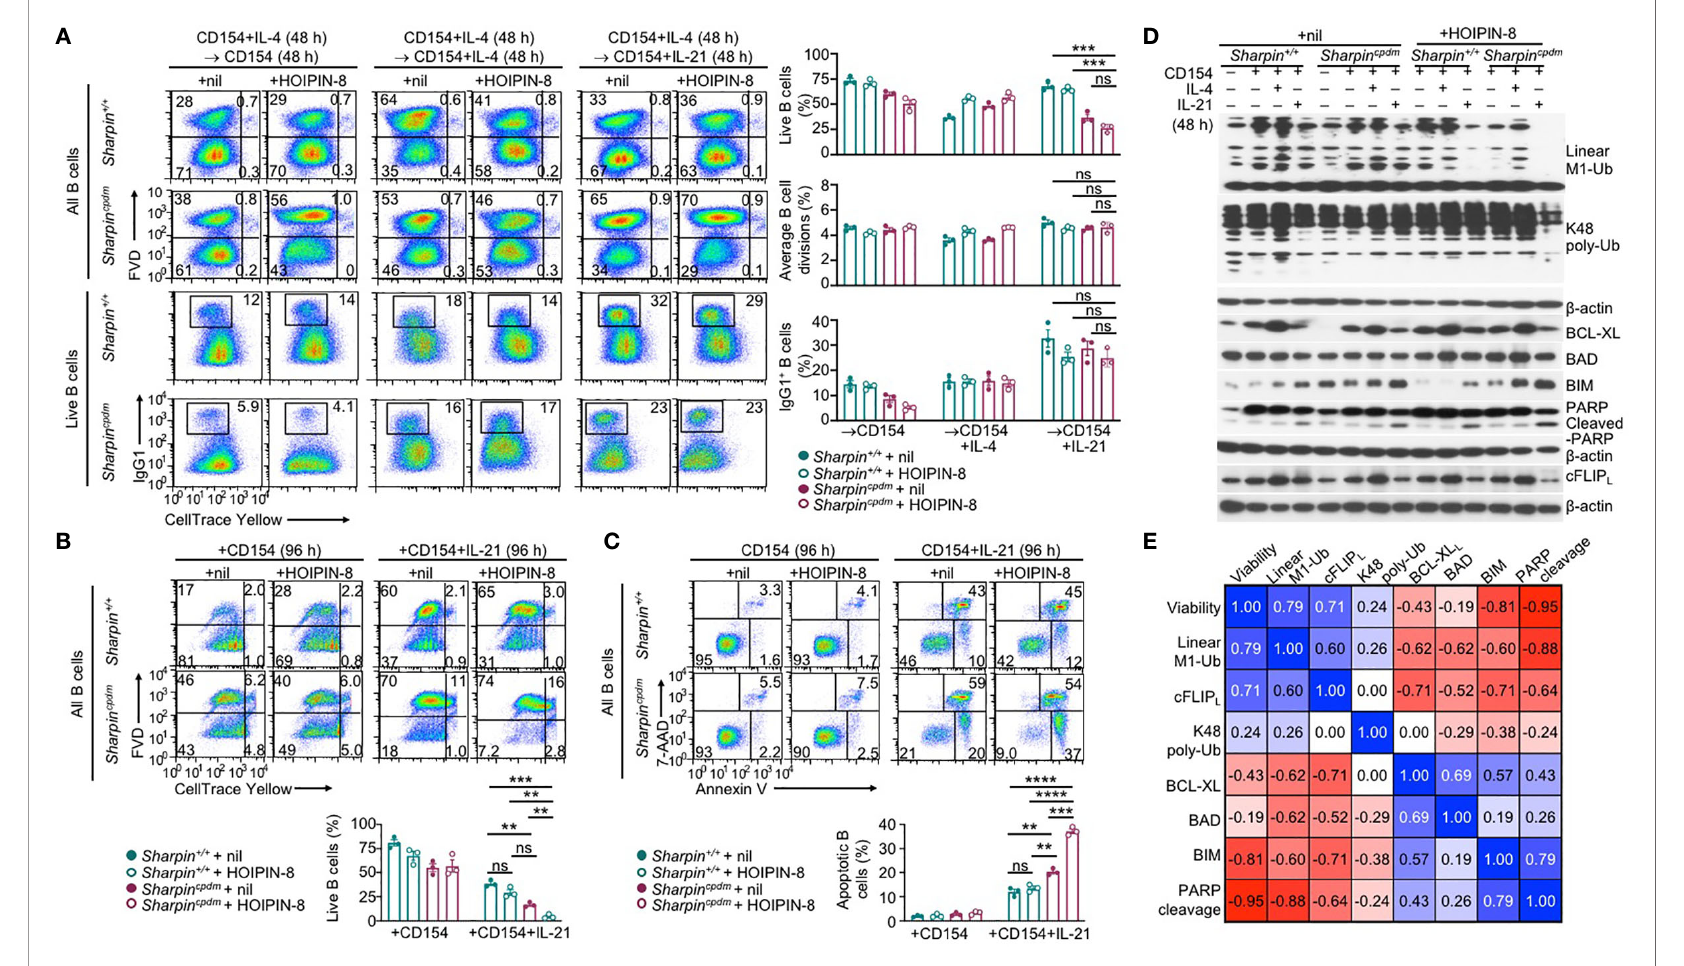
FIGURE 8 | SHARPIN de fi ciency and HOIPIN-8 synergize to promote IL-21-induced cFLIP L loss and apoptosis. (A) Flow cytometry analysis of survival, proliferation, and CSR to IgG1 in Sharpin +/+ and Sharpin cpdm B cells stimulated fi rst with CD154 and IL-4 for 48 h, washed, and then with CD154, alone or plus IL-4 or IL-21, for 48 h in the presence of nil or HOIPIN-8 (20 m M). (B) Flow cytometry analysis of the viability of Sharpin +/+ and Sharpin cpdm B cells stimulated with CD154 or CD154 plus IL-21 for 96 h in the presence of nil or HOIPIN-8. (C) Flow cytometry analysis of apoptosis in Sharpin +/+ and Sharpin cpdm B cells stimulated with CD154 or CD154 plus IL-21 for 96 h in the presence of nil or HOIPIN-8. (D) Immunoblotting analysis of linear M1-Ub, K48 poly-Ub, expression of apoptosis-related factors and PARP cleavage in Sharpin +/+ and Sharpin cpdm B cells freshly isolated or stimulated, as indicated, for 24 h. Representative of two independent experiments. (E) Pair-wise correlation of different parameters, as indicated, in Sharpin +/+ and Sharpin cpdm B cells stimulated with CD154 or CD154 plus IL-21 in the presence of nil or HOIPIN-8 for 96 h (to determine cell viability; data from were B ) or 24 h (other parameters; data were from D and Supplementary Figure 5D ). ** p < 0.01; *** p < 0.001; **** p < 0.0001;